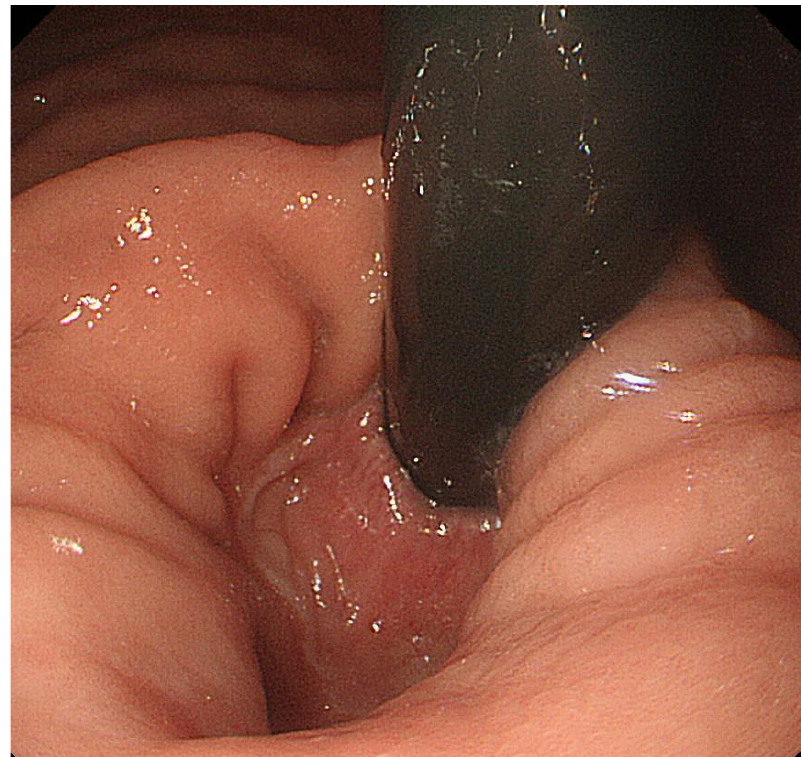
Figure 4. Although the squamocolumnar junction could not be observed even during the deep inspiration in the anterograde view from the esophagus (Figure 3), it could be observed in the retroflex view from the stomach. A pinstripe pattern in the esophageal body has been reported as an endoscopic find- ing in patients with achalasia in the early stages [23]. The pinstripe pattern is defined as the presence of longitudinal superficial wrinkles of the esophageal mucosa (Figure 5). The pinstripe pattern was observed in 60.7% of achalasia patients overall, and it was observed in 62.5% of patients with a history shorter than 10 years.